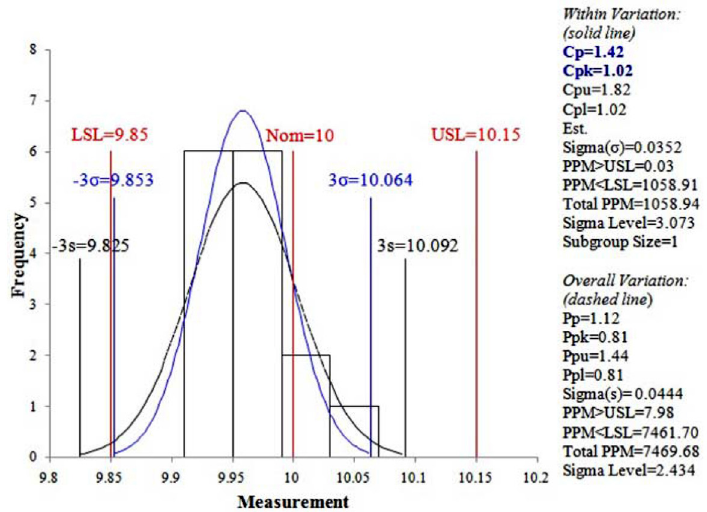
Fig. 6. Capability analysis of the proposed method